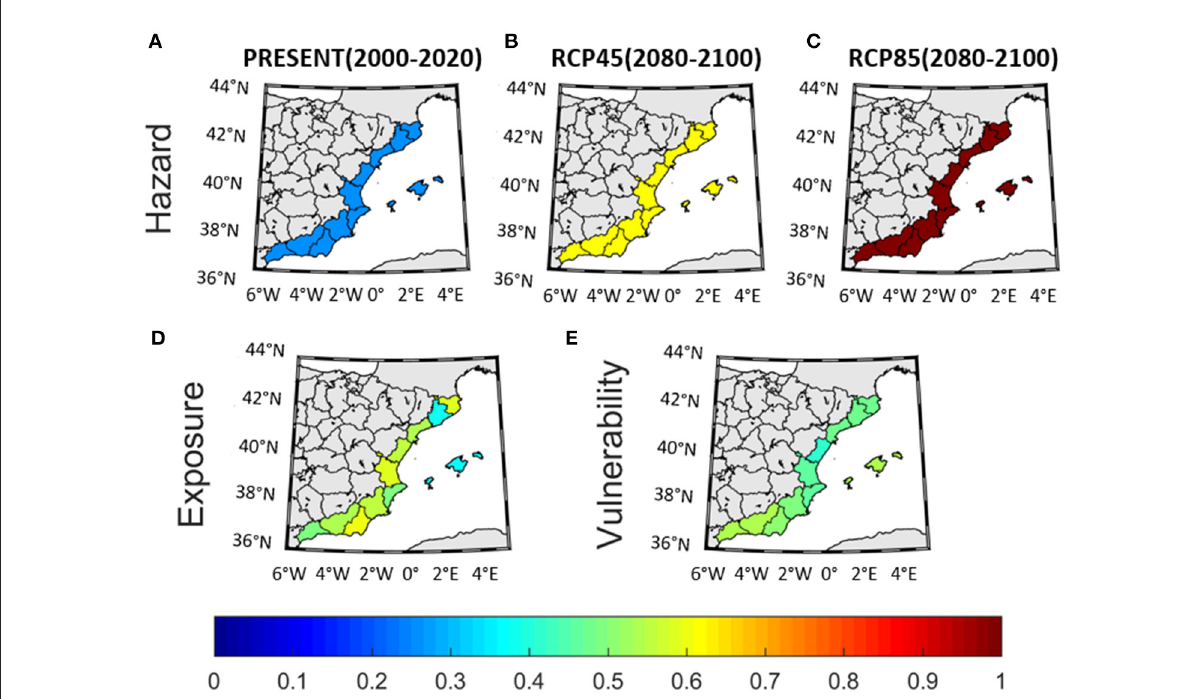
FIGURE7 Aggregated indicators for impact chain 2, corresponding to the “Risk of loss of attractiveness due to a reduction of beach availability”. (A) Hazard value in present conditions (200–2020), (B) at the end of the century (2080–2100) under RCP45 and (C) under RCP85. (D) Exposure and (E) Vulnerability. Note that (D,E) have the same values for present and